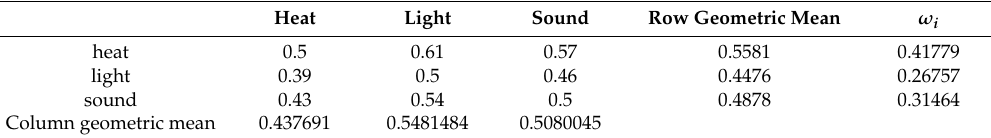
Table 5. Calculation results of row column geometric mean contrast legal